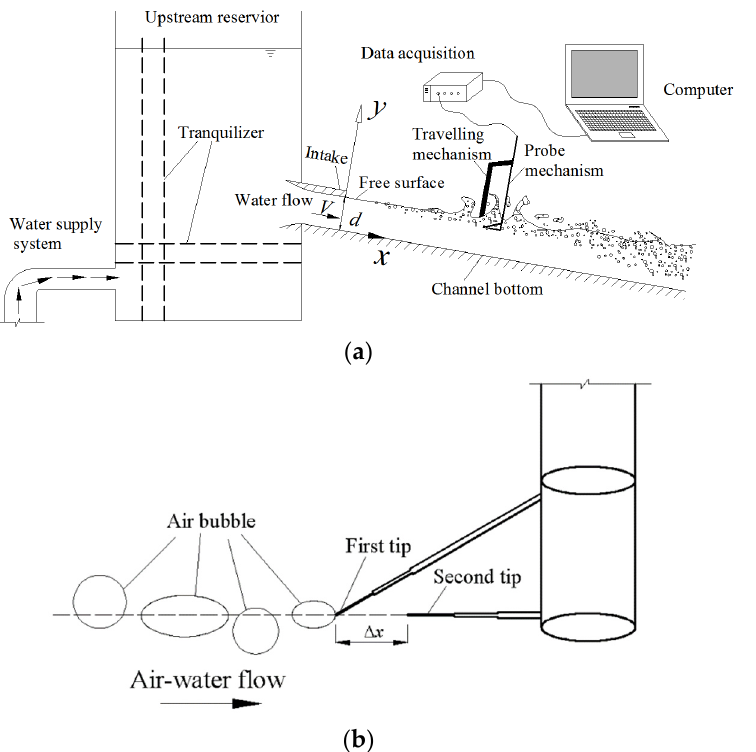
Figure 2. Sketch of experimental setup: ( a ) Schematic depiction of experimental configuration; ( b ) Sketch of the double-tip conductive probe. The two tips were aligned in the flow direction, and the distance between the two tips was ∆ x = 10 mm. The cross-correlation function between the two tip signals was the maximum value of the cross-correlation coefficient R for the average time T m taken for an “air bubble” interface to travel from the first tip to the second tip. The velocity was deduced from the time delay between the two tip signals and the two tip separation distance, ∆